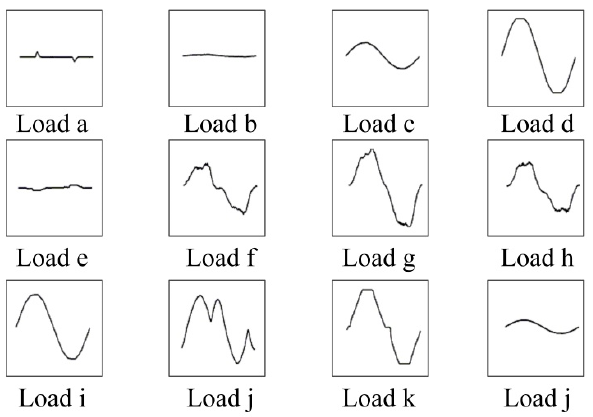
Figure 12. Input image of 12 separated current waveforms.